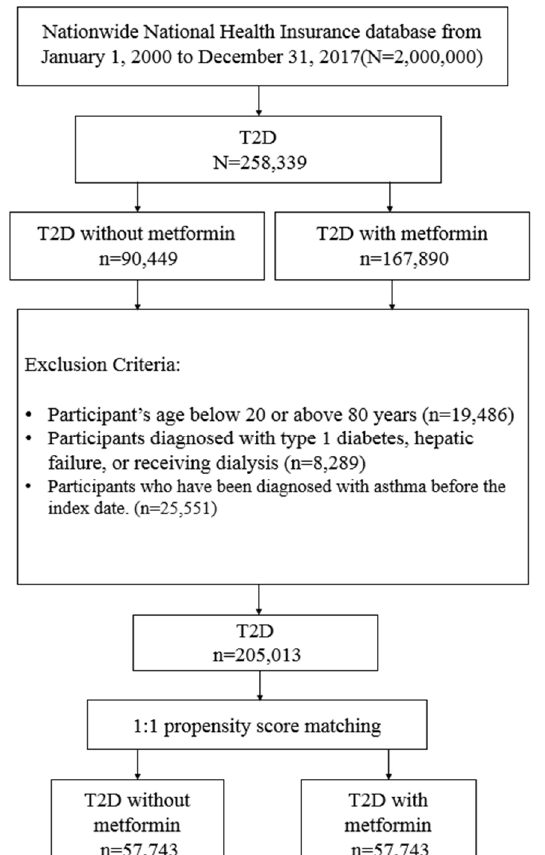
Figure 1. Process flow chart for the study.